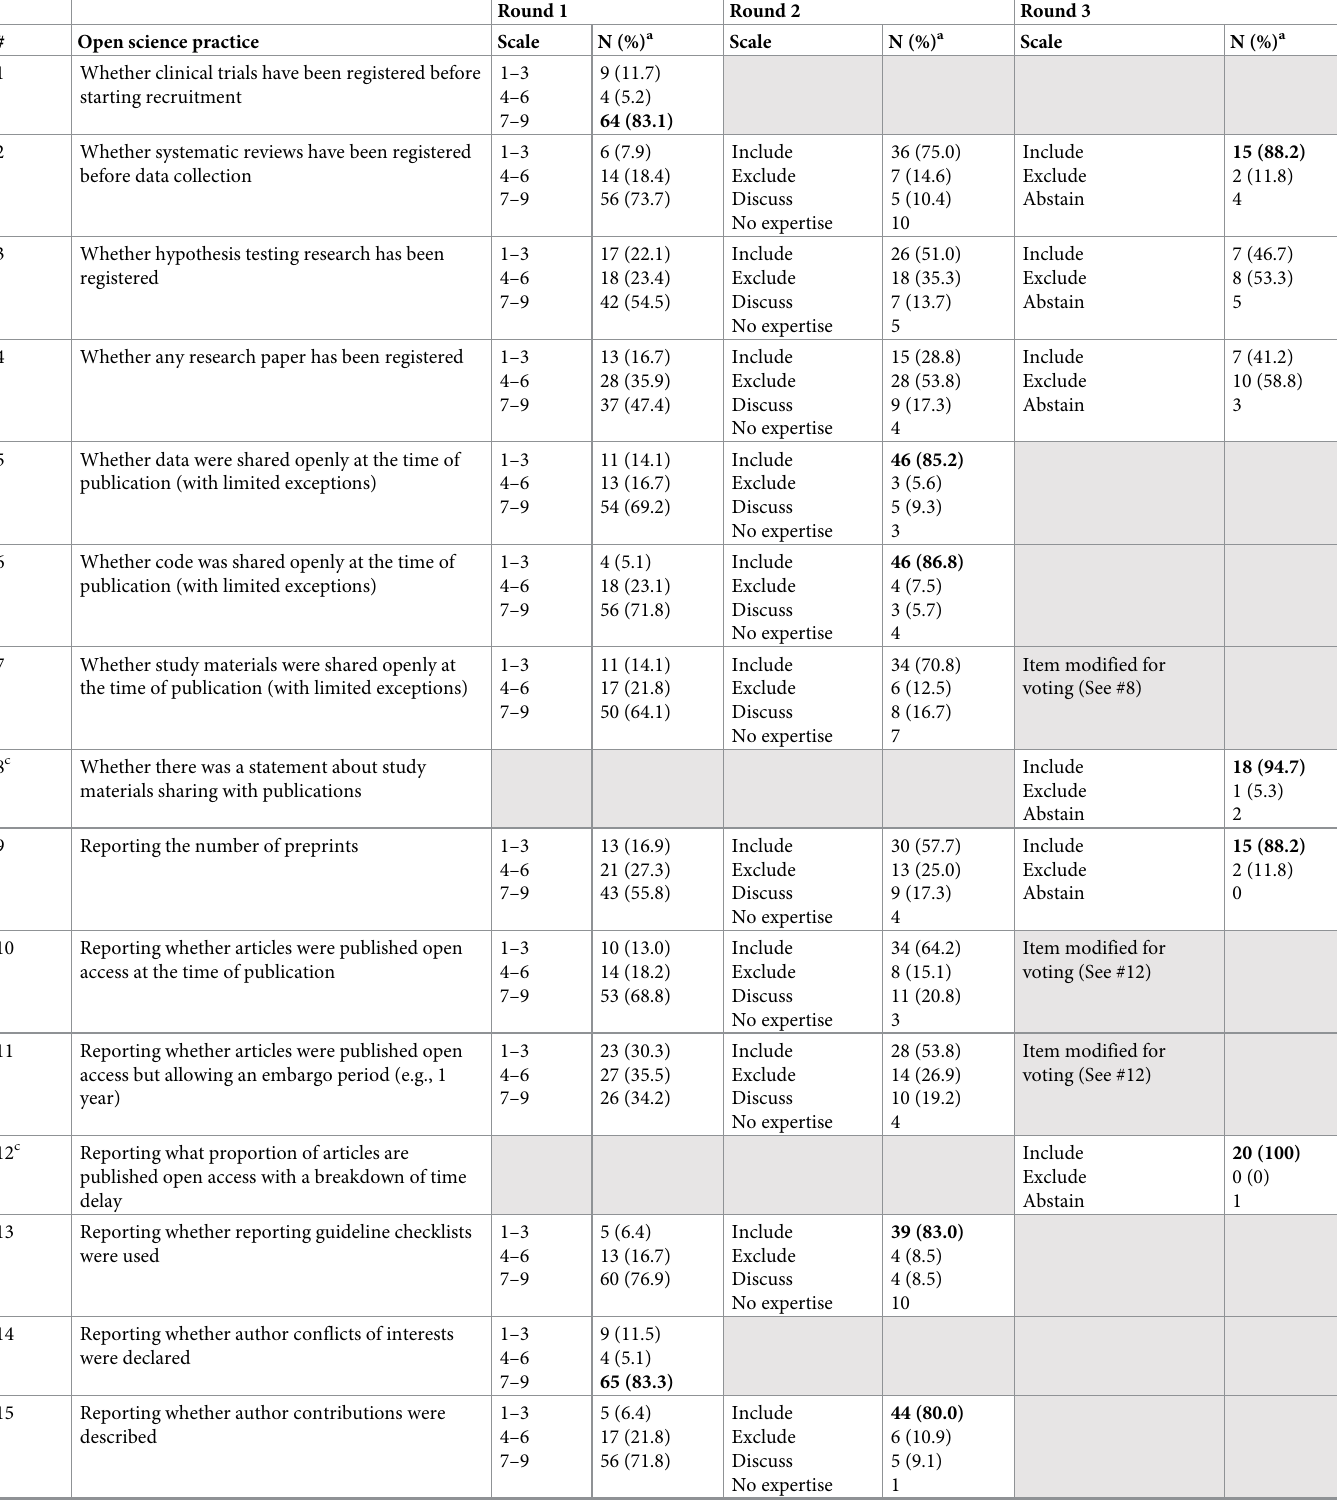
Table 2. Delphi voting results by